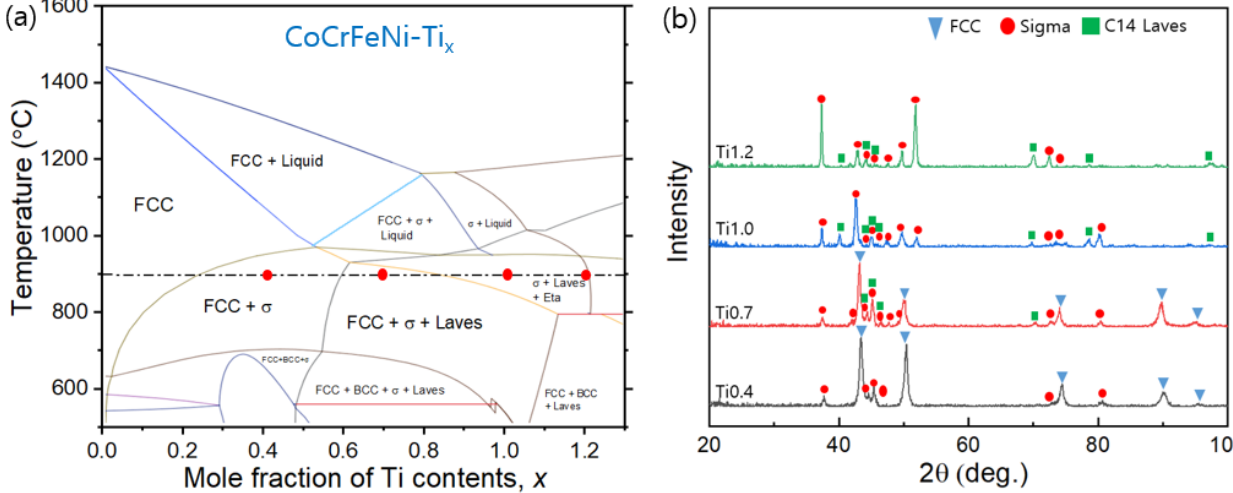
Figure 1. ( a ) The pseudo-binary CoCrFeNi-Ti phase diagram obtained by using the Thermo-Calc software with the thermodynamic database TCFE9; ( b ) XRD patterns of the CoCrFeNiTi x alloys with various Ti contents.